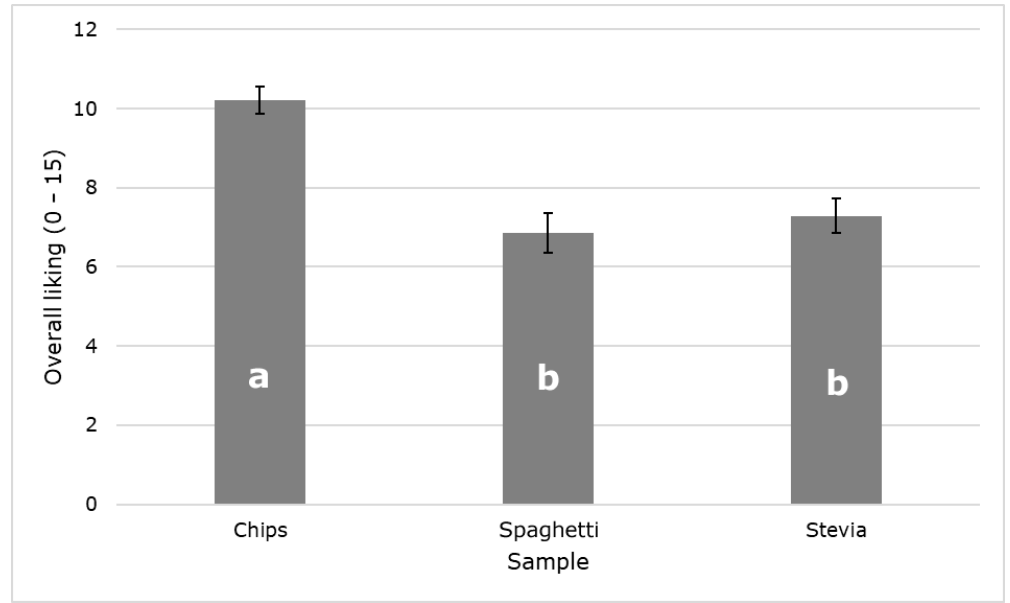
Figure 3. Mean values of the overall liking of the labels evaluated. Error bars represent the standard error. Different letters denote significant differences based on the ANOVA and Tukey honest significant difference (HSD) post hoc test ( α =